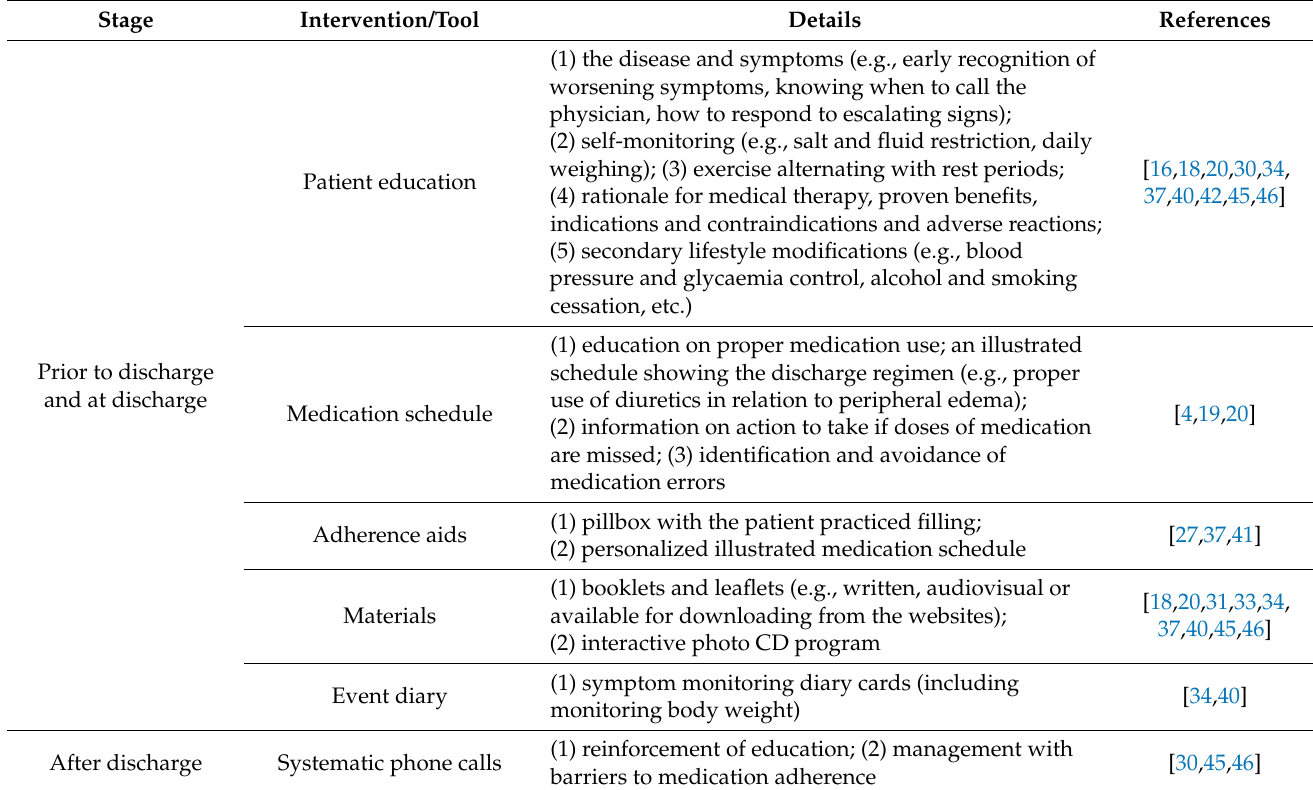
Table 3. Summary of educational interventions according to reviewed